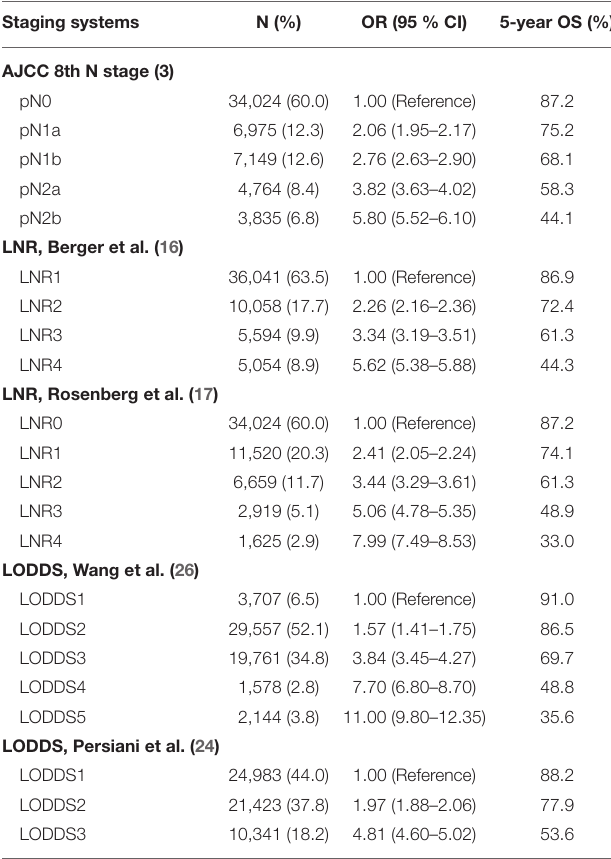
TABLE 3 | Five-year overall survival and 95% confidence interval according to different LN staging. Staging